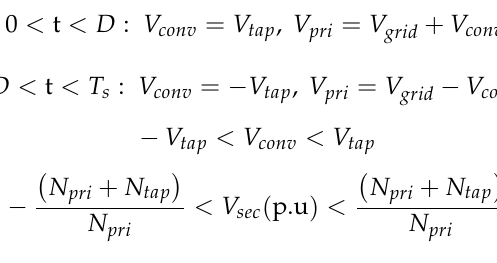
Figure 3. Circuit configuration of one stage active hybrid solid state transformer.